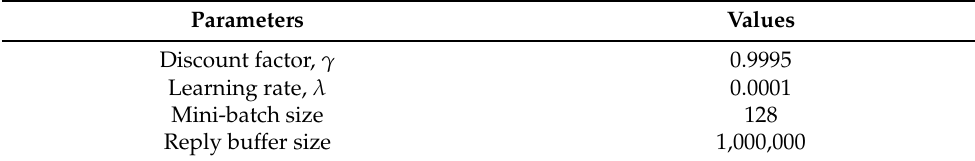
Table 3. Parameters settings of the